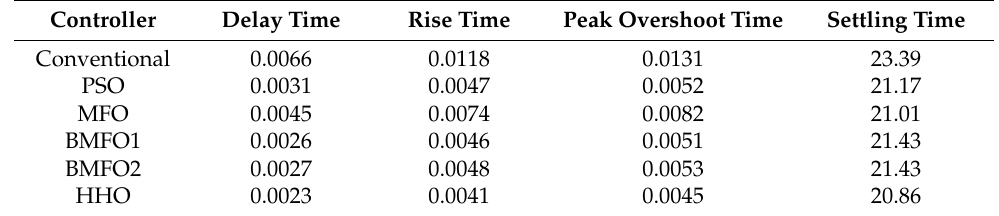
Table 10. Graph analysis of Area2 frequency with various controllers under bilateral